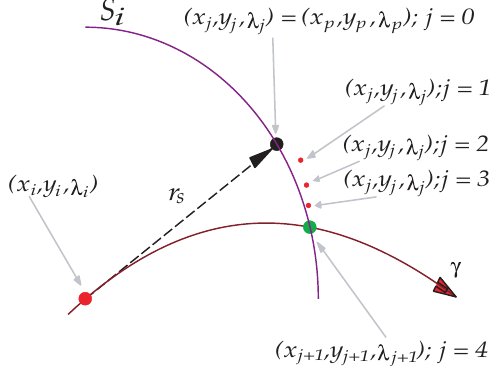
Figure 4. Representation of the predictor–corrector